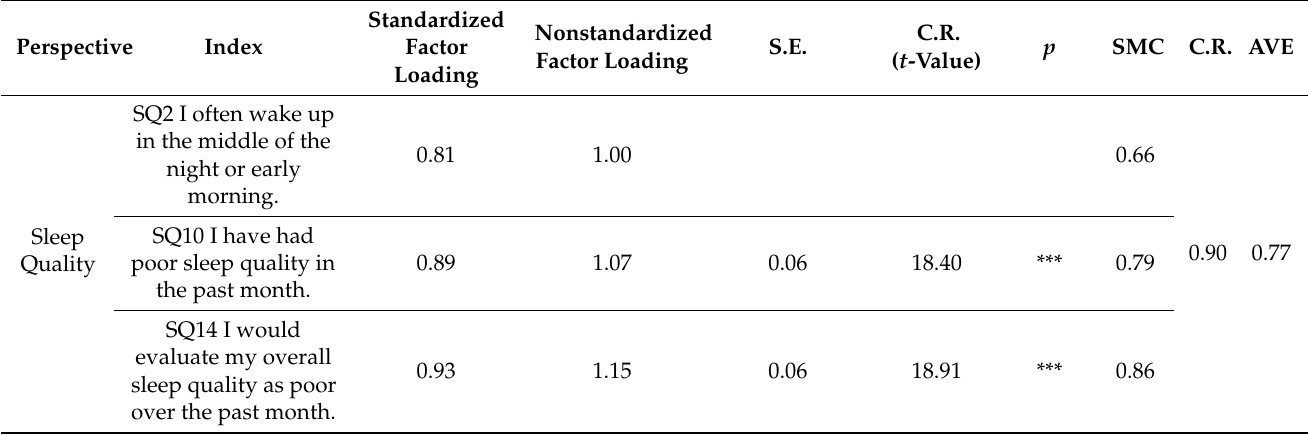
Table 4. Sleep Quality—confirmatory factor analysis reached a significant level.